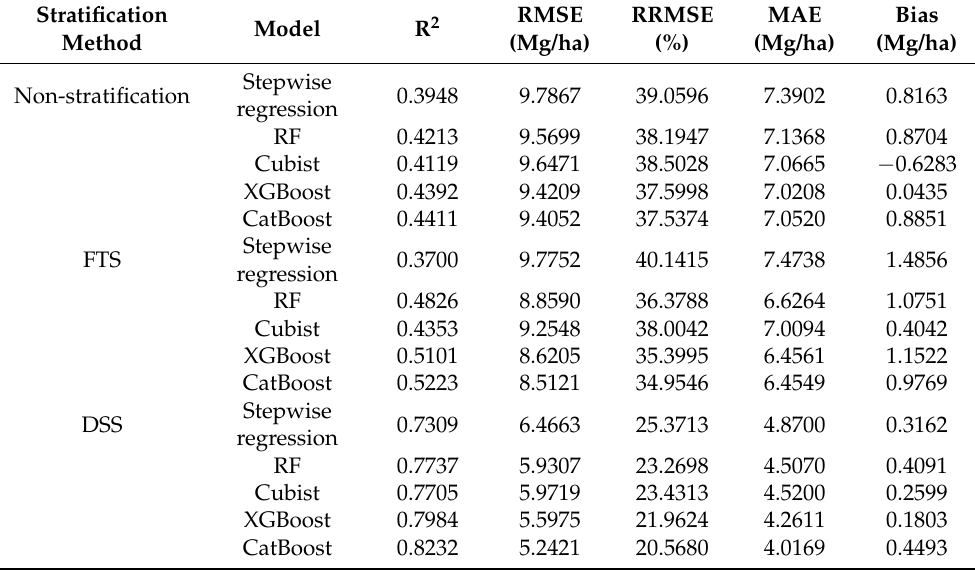
Table 8. Summary of the overall estimation accuracy of non-stratification, FTS and DSS models on the validation